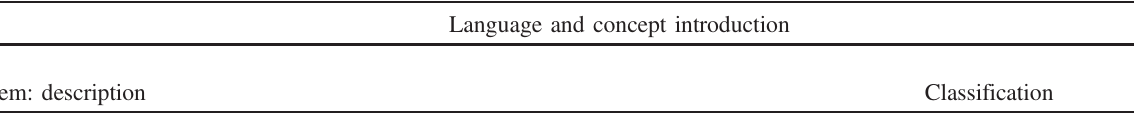
TABLE II. Coding scheme and number of books in each